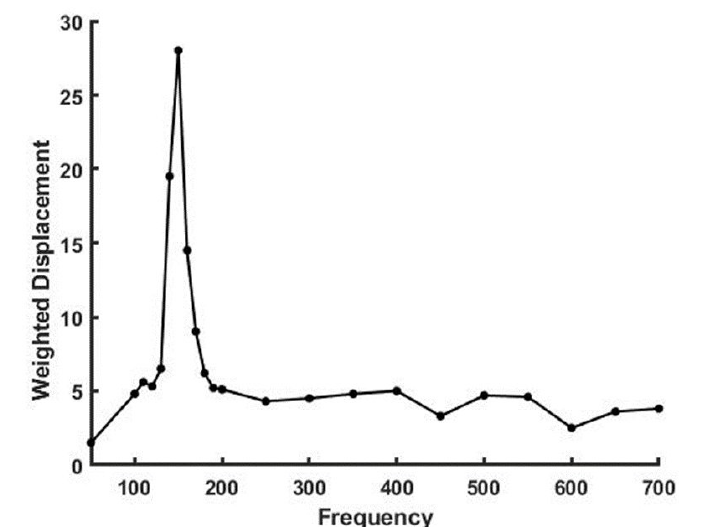
Figure 1. Vibrational analysis of decellularized dermis in vitro composed primarily of type I col- lagen. The modulus is determined from the frequency at which the maximum displacement is ob- served and the sample thickness using Equation